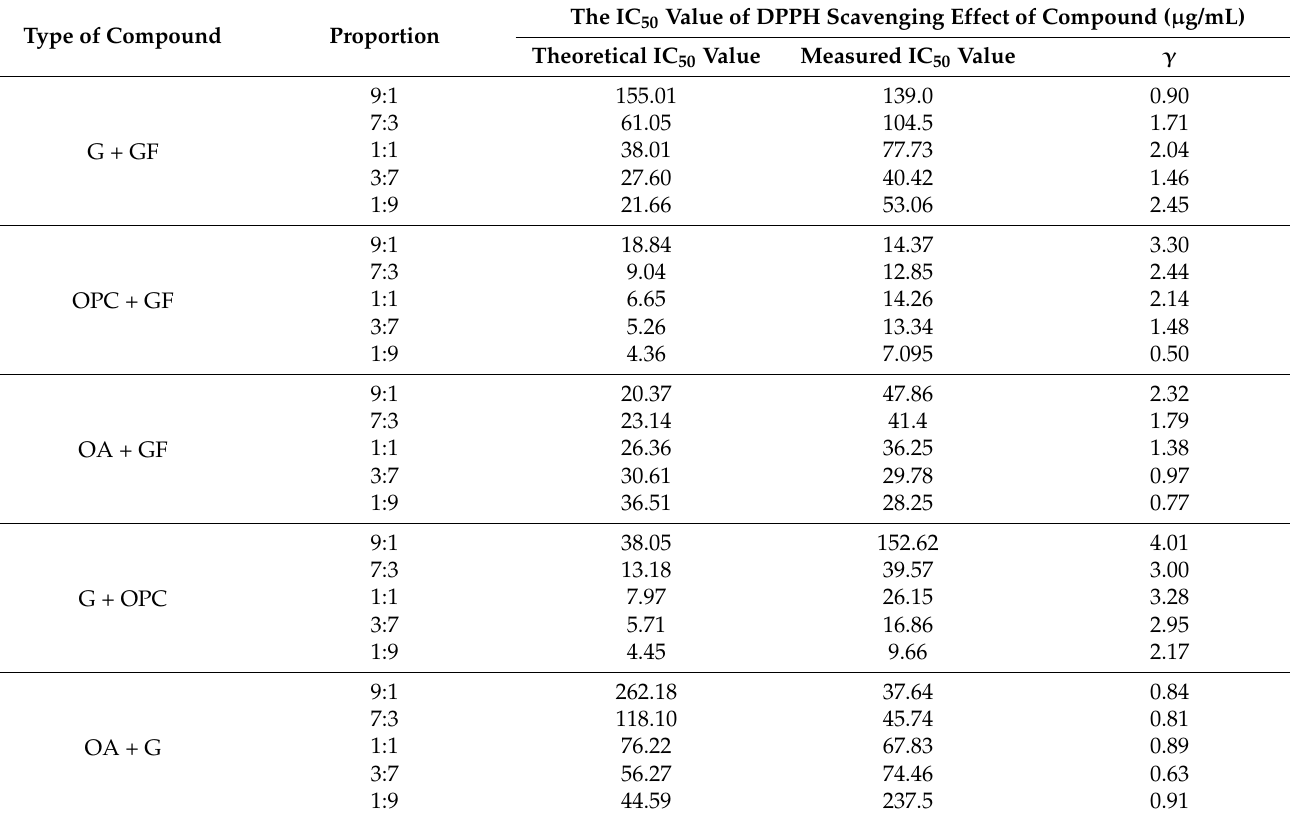
Table 2. Synergistic effect of functional components of EGb scavenging DPPH free radical. Type of